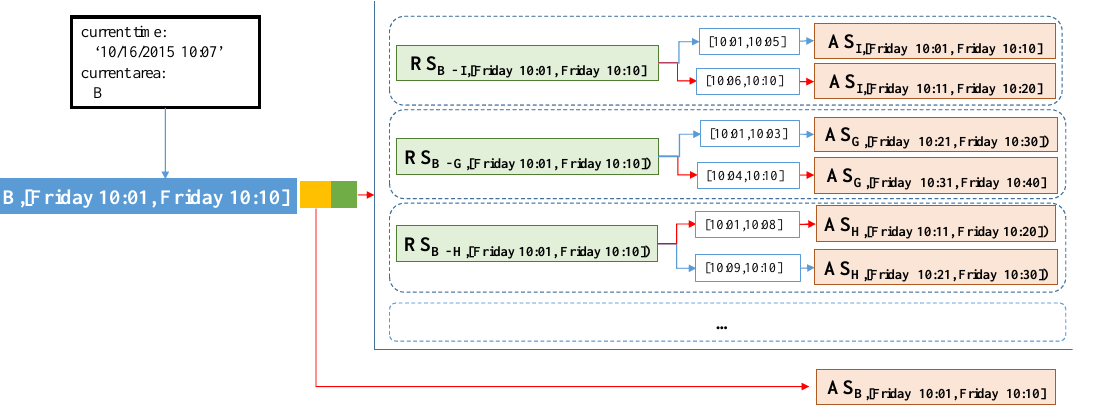
Figure 10. An extend route